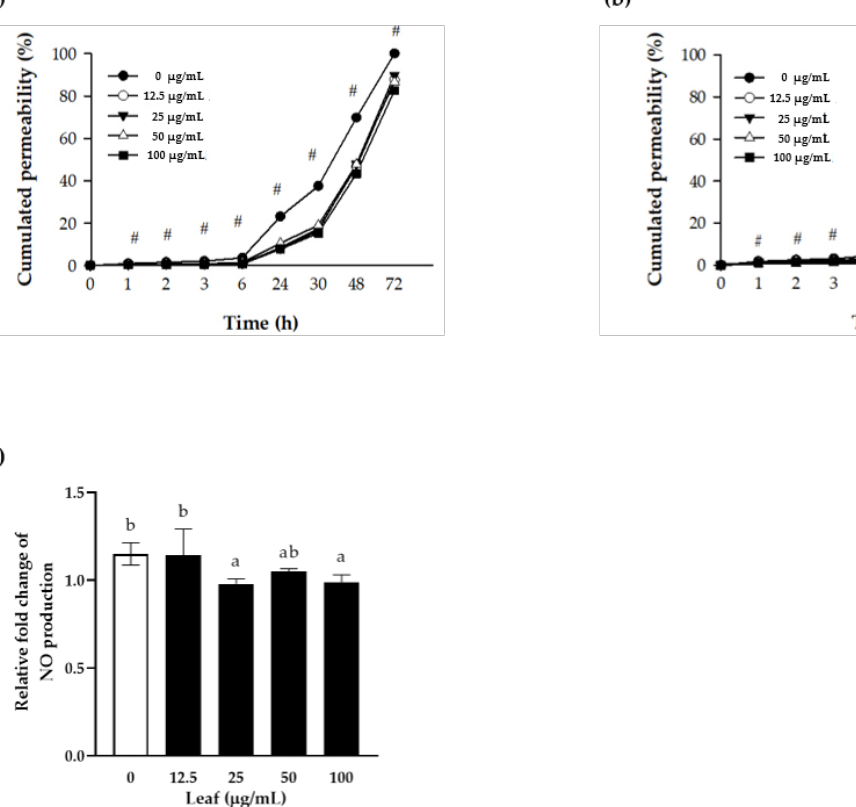
Figure 3. Protective effect of LL on the cell permeability. Polarized Caco-2 cells were pretreated with the indicated concentrations of LL for 24 h, followed by stimulation without ( a ) or with ( b ) cytokine cocktail (50 ng/mL TNF- α + 50 ng/mL IFN- γ + 25 ng/mL IL1 β + 10 µ g/mL LPS) apically for an additional 24 h. One mg/mL of FITC-dextran fluorescein was added to the apical side, and the absorbance was measured at the indicated time point in the conditional media from the basal side. Before adding FITC-dextran, the conditional media from the apical side were harvested for the NO assay to measure NO production ( c ). The white bar represents negative control set as 1.0. Data are shown as the means ± SD of at least three independent experiments. Significant differences between different concentrations were analyzed using Duncan’s multiple range test with one-way ANOVA and values labeled with different letters are significantly different ( p < 0.05). Significant different value compared to the control group was analyzed using a student’s t -test.* p < 0.05, # p < 0.001. LL: Lycium barbarum leaf.